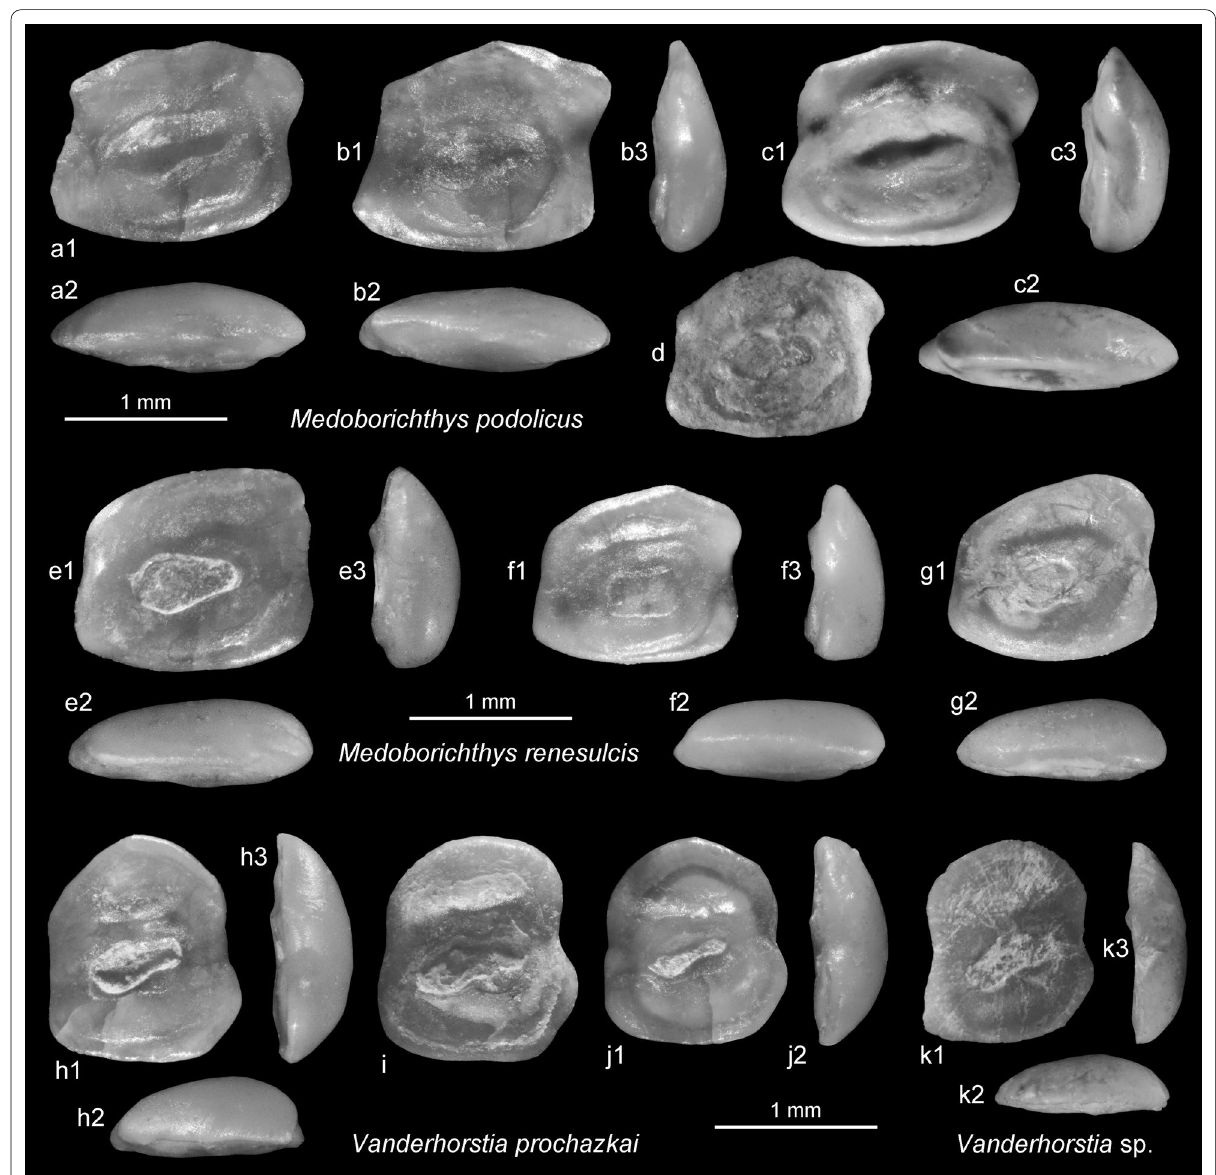
Fig. 6 Otoliths of Medoborichthys and Vanderhorstia : a – d Medoborichthys podolicus n. gen. et n. sp., b holotype, NMNHU-P PI 2563, Mlyntsi, a , c , d paratypes, a Mlyntsi, NMNHU-P PI 2564, c Shydlivshchyna, NMNHU-P PI 2565, d (reversed) Kozatskyi Yar, NMB P1215. e – g Medoborichthys